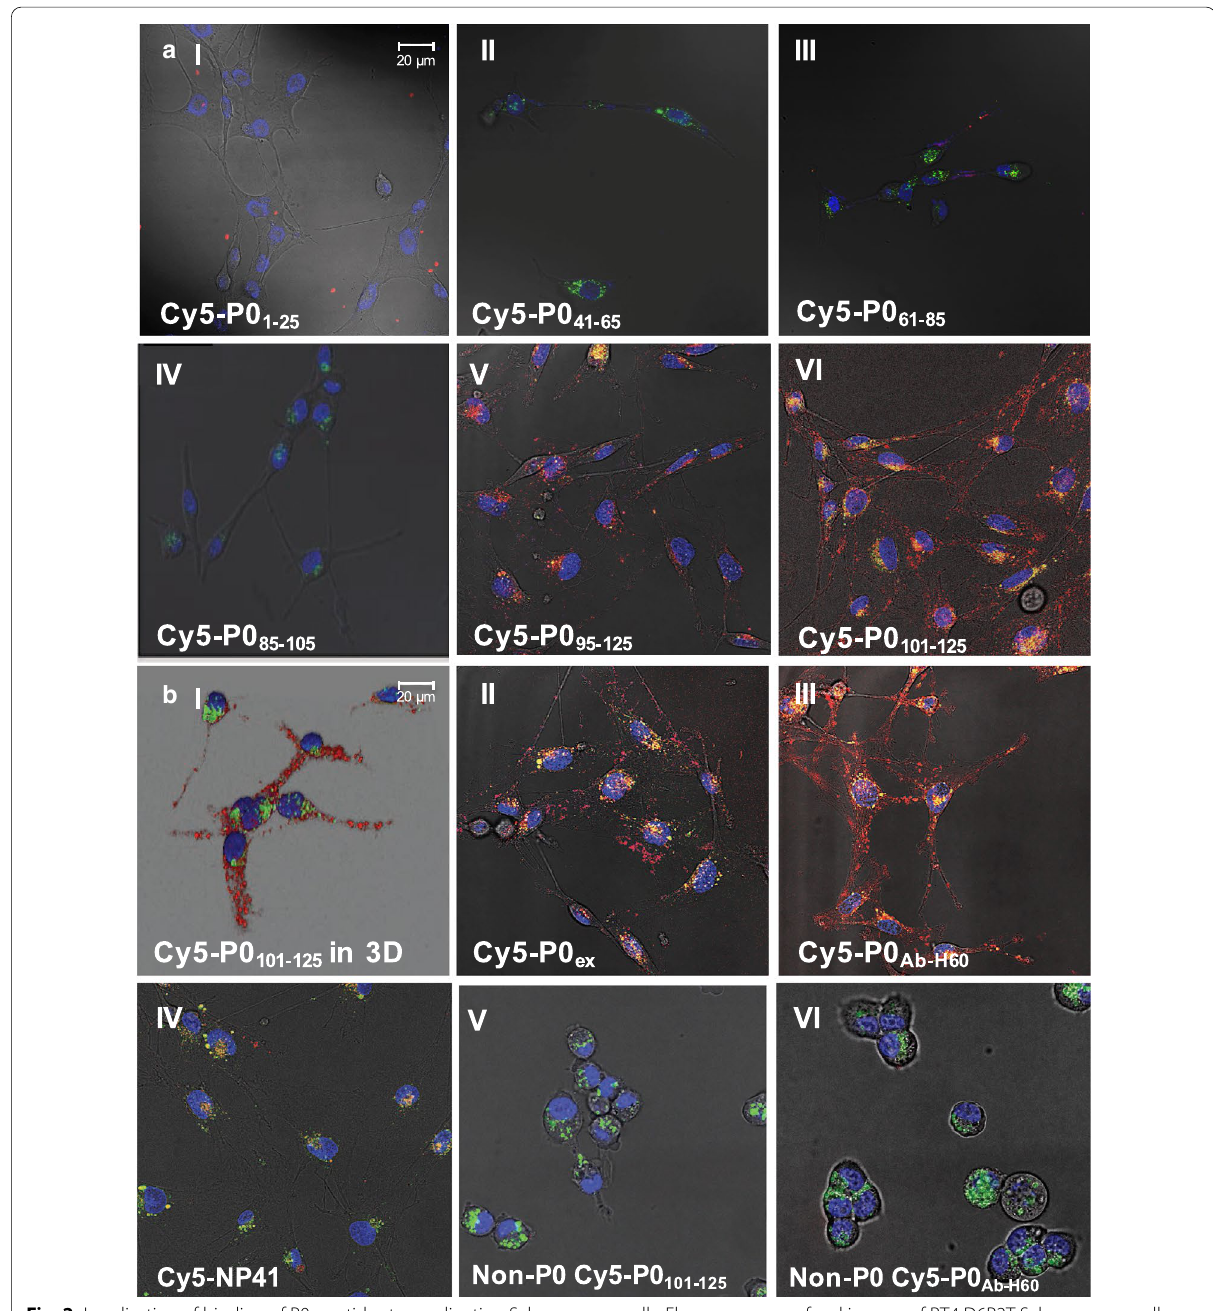
Fig. 2 Localization of binding of P0 peptides to myelinating Schwannoma cells. Fluorescence confocal images of RT4 D6P2T Schwannoma cells after incubation with A C-terminally Cy5-labelled P0 1–25 ( Cy5-P0 1–25 ; I), P0 41–65 ( Cy5-P0 41–65 ; II), P0 61–85 ( Cy5-P0 61–85 ; III), P0 85–105 ( Cy5-P0 185–105 ; IV), P0 95–120 ( Cy5-P0 95–125 ; V) or P0 101–125 ( Cy5-P0 101–125 ; VI). B Fluorescence confocal images of RT4 D6P2T Schwannoma cells after incubation with Cy5-P0 95–120 represented in 3D (I), and the extracellular portion of P0 ( Cy5-P0 ex ; II), Cy5-labelled anti-P0 antibody clone H60 ( Cy5-P0 Ab-H60 ; III), a non-P0-specific peptide ( Cy5-NP41 ; IV). Staining of non-P0-expressing MDAMB 468 cells with Cy5-P0 101–125 (V), Cy5-P0 Ab (VI) and Cy5-Maleimide (CI) were used to show specificity for P0. Blocking experiments showed a clear decrease in the mean fluorescence intensity for Cy5-P0 101–125 after pre-incubation with P0 Ab (II). Quantification of fluorescence intensity with and without blocking (III; Cy5-P0 101–125 in red, blocked conditions in black) further underlined specificity ( p 0.001). In all confocal images, Cy5 is represented in red, nuclear staining (Hoechst) in blue and lysosomes = (lysotracker green) in